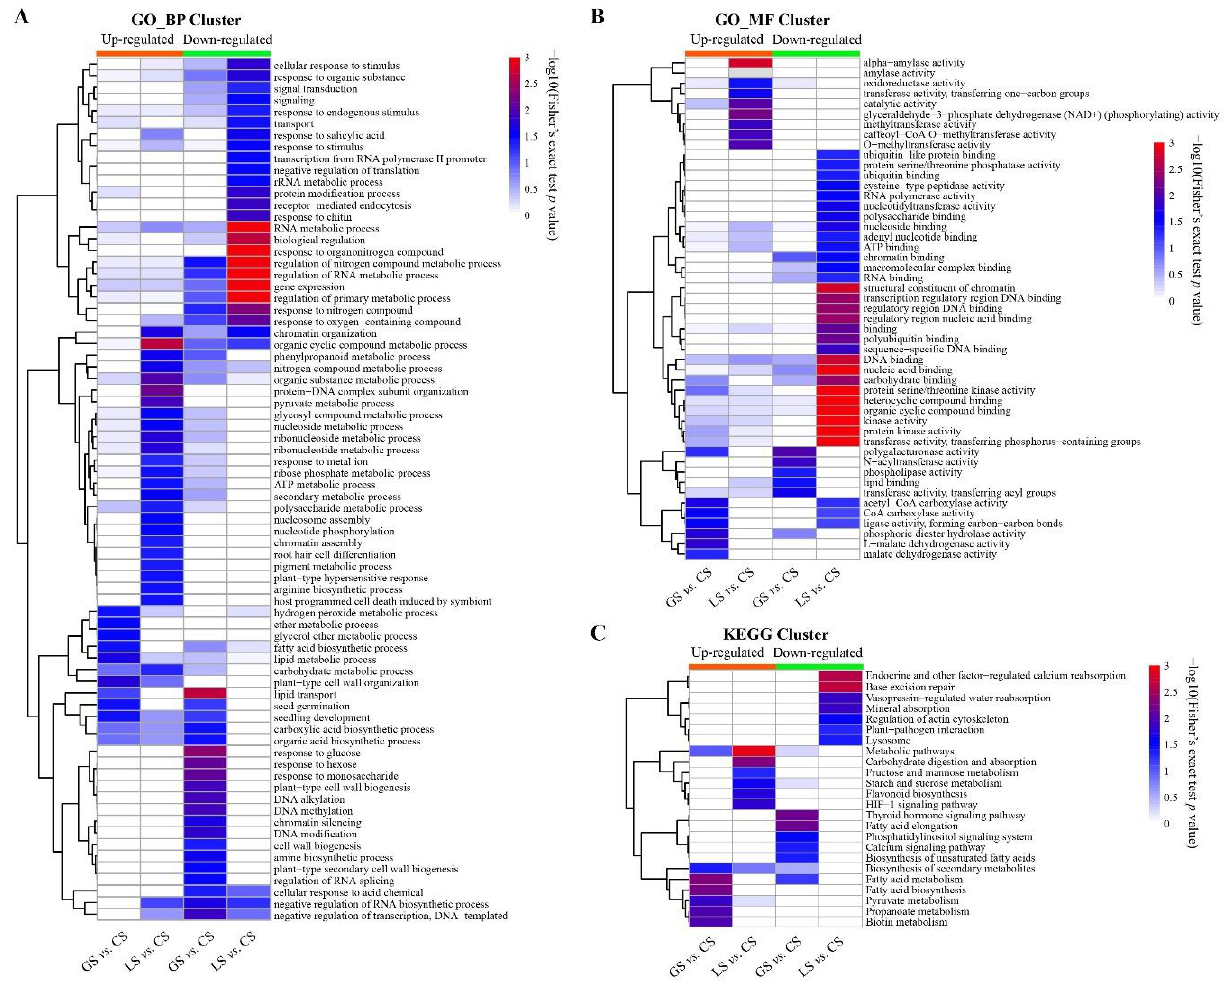
Figure 5. Functional annotation and enrichment analysis of DAPs specifically regulated by LS and GS substrates: ( A ) cluster analysis of enriched gene ontology_biological process (GO_BP) functional terms; ( B ) cluster analysis of enriched gene ontology_molecular function (GO_MF) functional terms; and ( C ) enrichment-based cluster analysis of KEGG pathway.